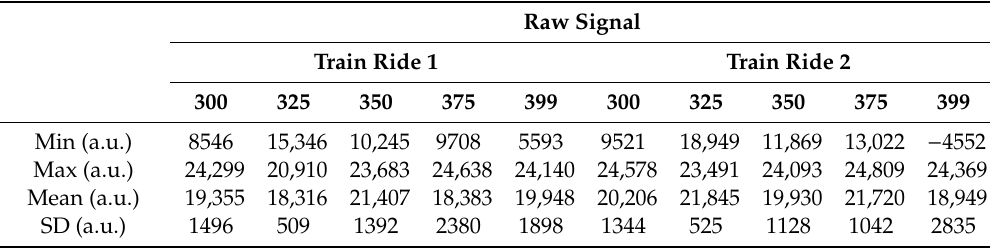
Table 3. Statistical values of the measurement as two trains in the same composition pass through channels 300, 325, 350, 375 and 399 on the same day. Raw Signal Train Ride 1 Train Ride 2 300 325 350 375 399 300 325 350 375 399 Min (a.u.) 8546 15,346 10,245 9708 5593 9521 18,949 11,869 13,022 − 4552 Max (a.u.) 24,299 20,910 23,683 24,638 24,140 24,578 23,491 24,093 24,809 24,369 Mean (a.u.) 19,355 18,316 21,407 18,383 19,948 20,206 21,845 19,930 21,720 18,949 SD (a.u.) 1496 509 1392 2380 1898 1344 525 1128 1042